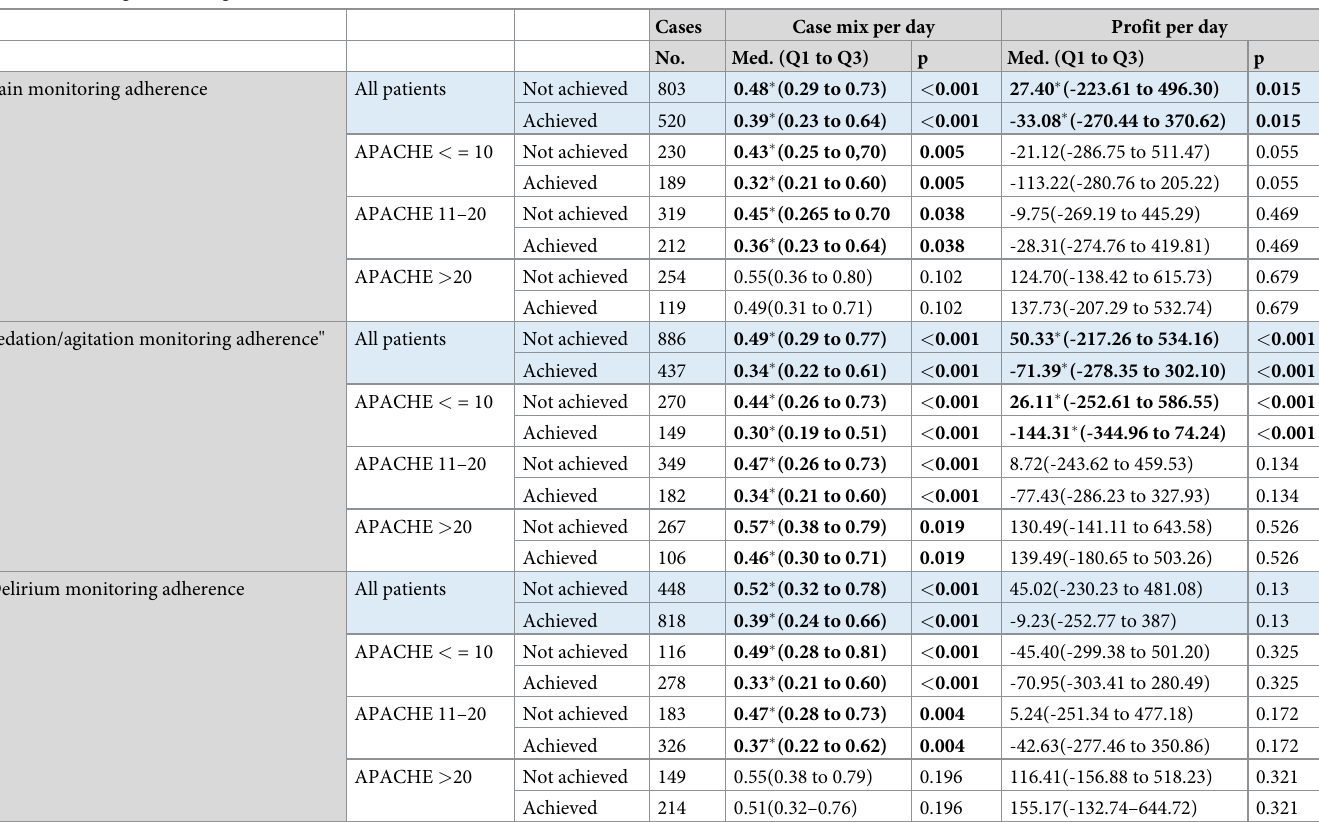
Table 3. Relating monitoring and economic outcome.